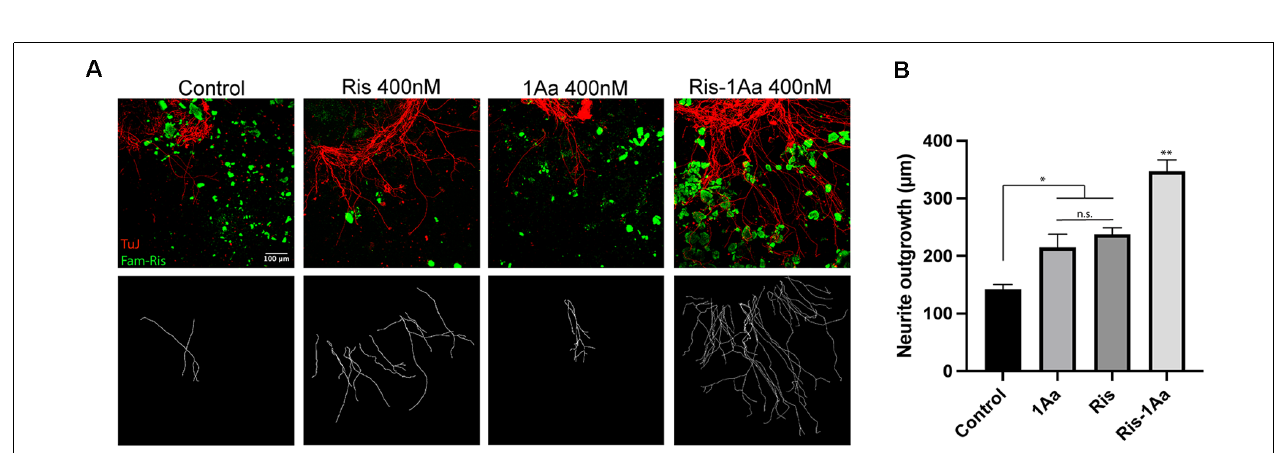
FIGURE 4 | Ris-1Aa supports neurite outgrowth in vitro in a manner comparable to 1Aa. (A) SGN neurite outgrowth in vitro . Neurites were stained with neuronal marker TuJ (red), and nuclei were labeled with DAPI (blue). Scale bar represents 100 µ m. Images are representative of seven independent experiments. (B) Quantification of neurite outgrowth compared to DMSO control ( ∗∗∗ represents p ≤ 0.001).